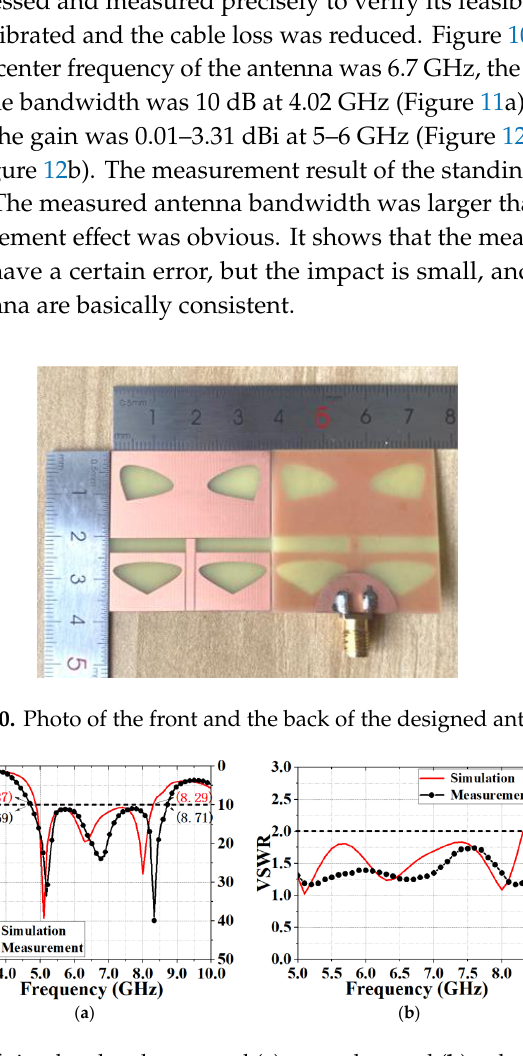
Figure 11. Comparison of simulated and measured ( a ) return loss and ( b ) voltage standing wave ratio (VSWR) of the designed antenna.